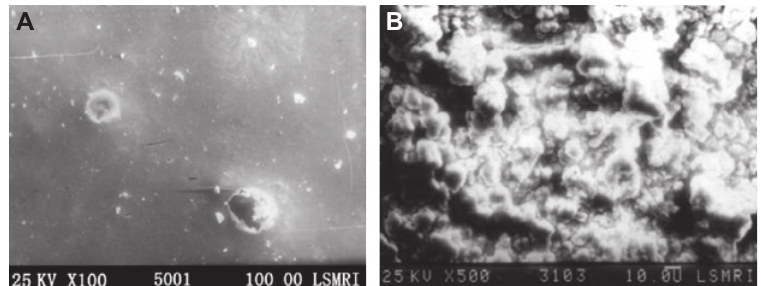
Figure 5 SEM micrographs of organic coatings in the